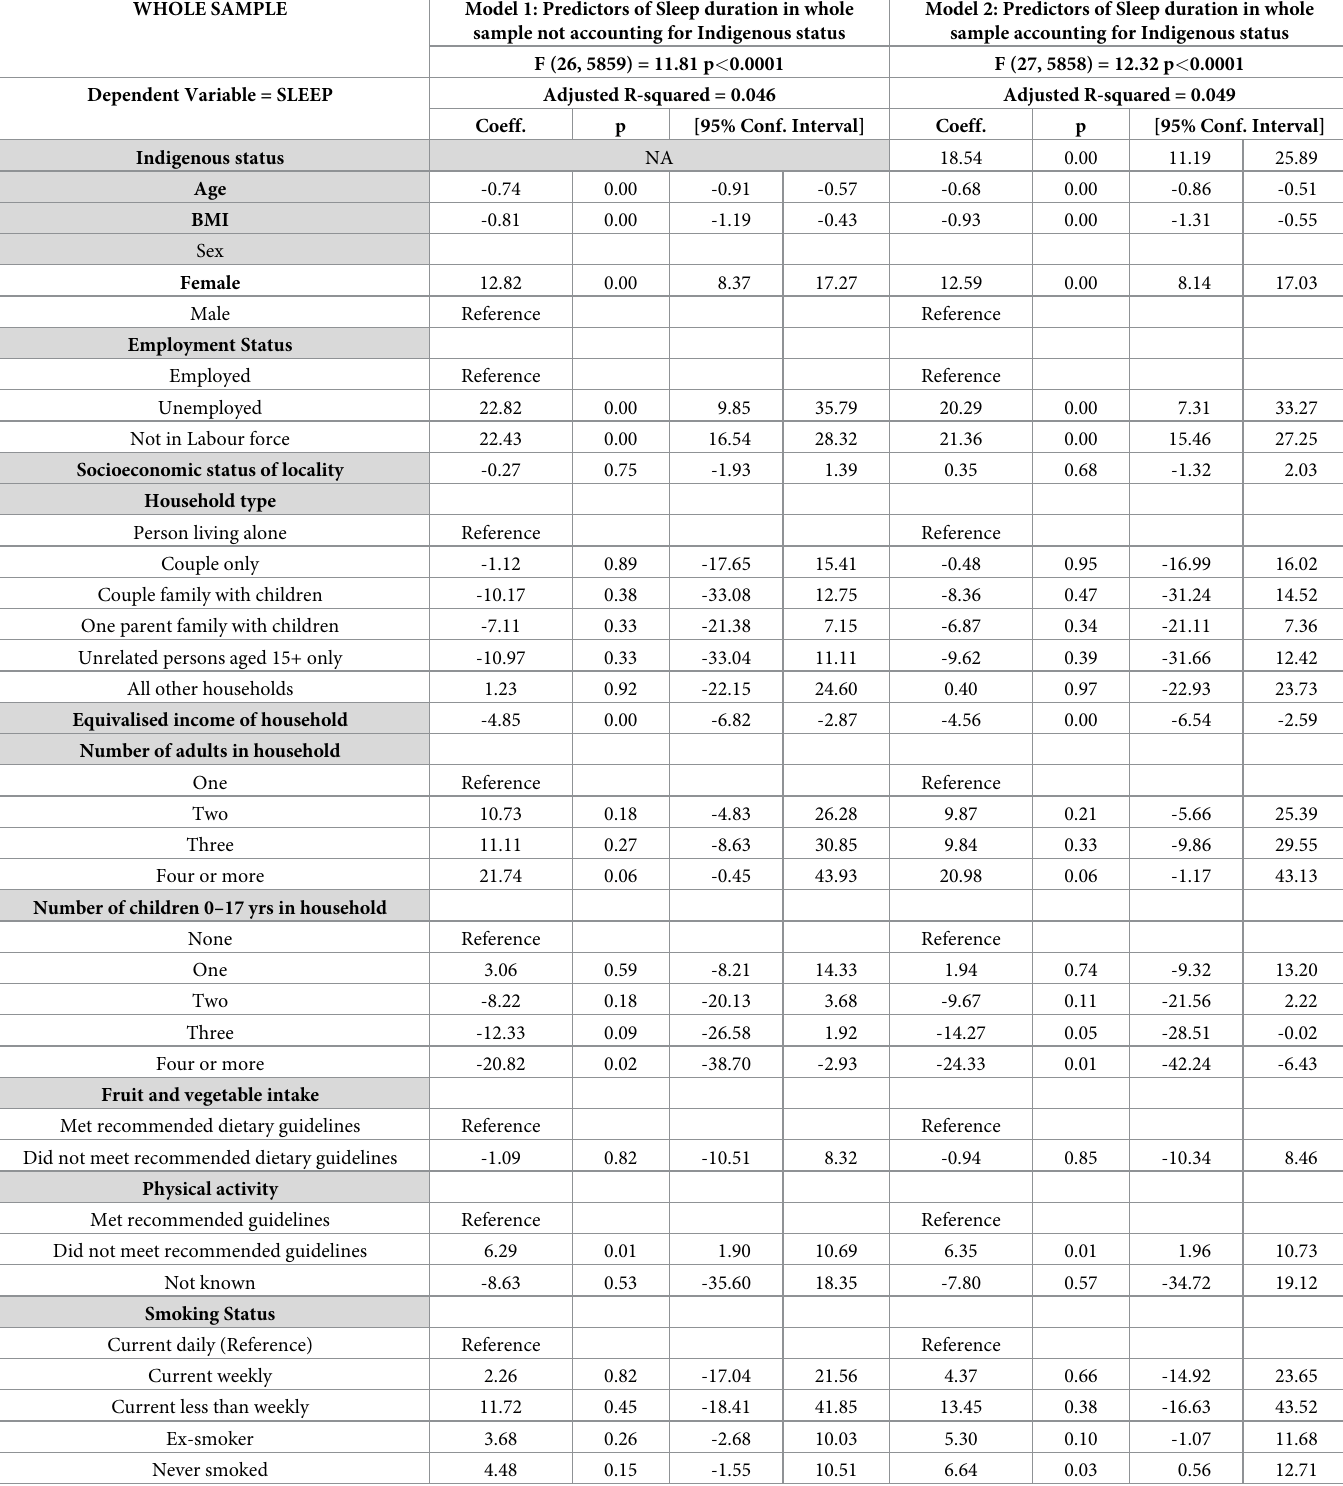
Table 2. Predictors of sleep duration. WHOLE SAMPLE Model 1: Predictors of Sleep duration in whole sample not accounting for Indigenous status